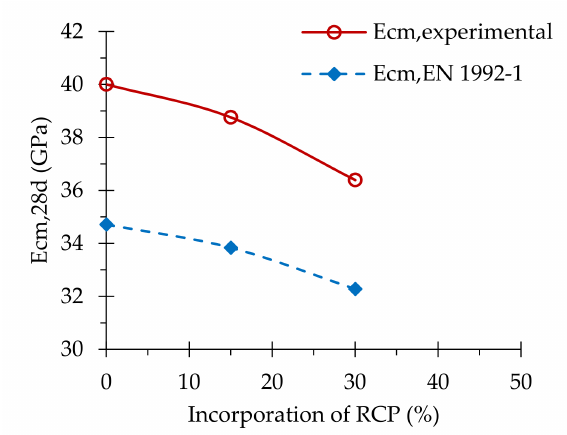
Figure 20. Modulus of elasticity at 28 days, E cm ,28 d , of concrete with w/b of 0.55 and different percentages of RCP at 28 days and estimated through EN 1992-1